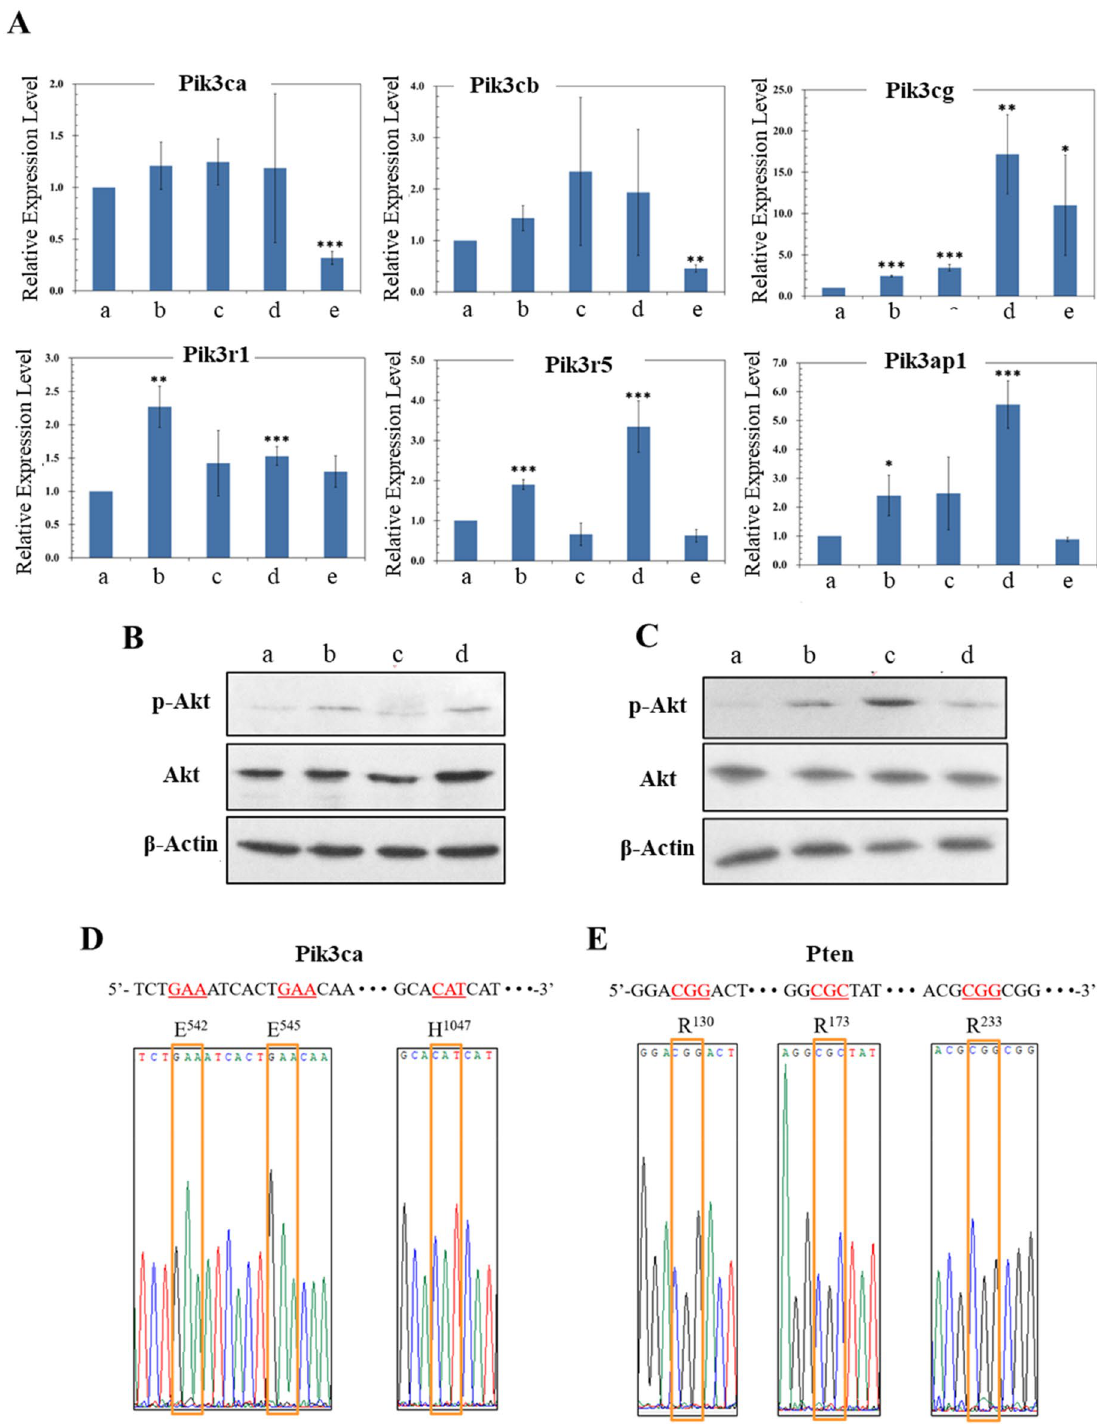
Figure 5. Analyses of PI3K/Akt signalling potential of miPS-PGE2P cells. ( A ) RT-qPCR analyses of pik3 related genes expression. a: miPSCs, b: miPS-LLCcm, c: miPS-PGE2, d: miPS-LLCcmP, e: miPS-PGE2P. Data are plotted as means ± SD. * p < 0.1, ** p < 0.05, *** p < 0.01. ( B , C ) Western blotting analysis of the phosphorylation of Akt. ( B ) Cells after conversion of iPSCs. a: miPSCs -LIF, b: miPSCs + LIF, c: miPS-LLCcm, d: miPS-PGE2. ( C ) Primary cells derived from tumors of miPS-LLCcm and miPS-PGE2 cells. a: miPSCs -LIF, b: miPSCs + LIF, c: miPS-LLCcmP, d: miPS-PGE2P. ( D , E ) DNA sequence spots of oncogenic mutations in pik3ca and PTEN genes were analysed in miPS-PGE2P cells. The sequencing charts corresponding to each part of sequences are shown together with normal sequence and translated amino acids on the top. ( D ) pi3kca gene ( E ) PTEN gene. The ID numbers of the template sequences are BC089038.1 in EMBL and NM_008960.2 in GenBank. Each codon shown in red is the part subjected to occasional oncogenic mutation in cancer (COSMIC < https:// cancer. sanger. ac. uk/ cosmic